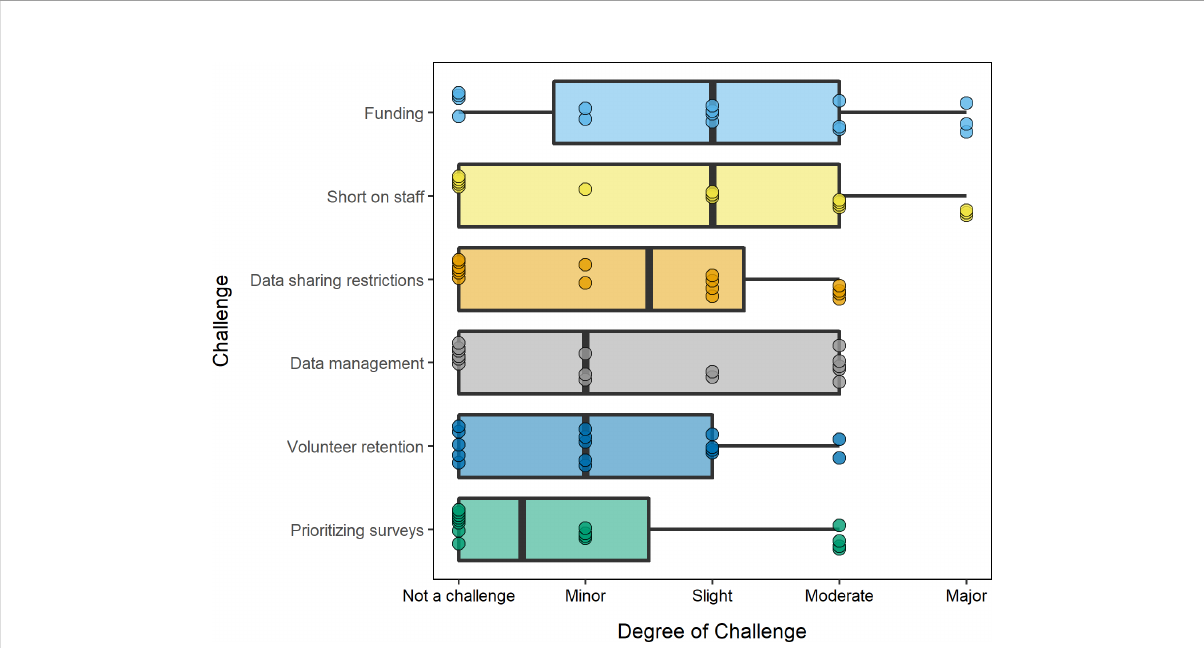
FIGURE 1 Boxplot of challenges that projects face ranked by degree of challenge as indicated by project managers from a major challenge to no challenge. The two major challenges community science projects face are limited funding and too few staff. Data sharing restrictions and data management are the primary moderate challenges that projects face. Volunteer retention is a slight challenge, and prioritizing taxa or locations to monitor is a minor